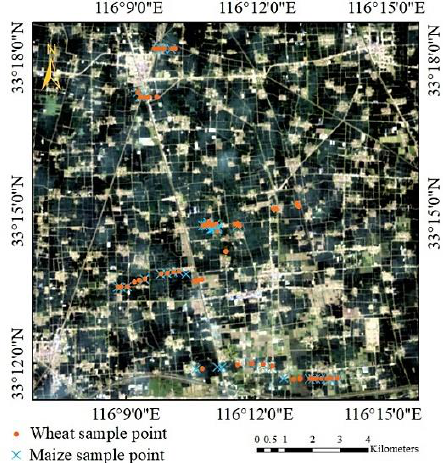
Figure 2. Location of yield sample points.